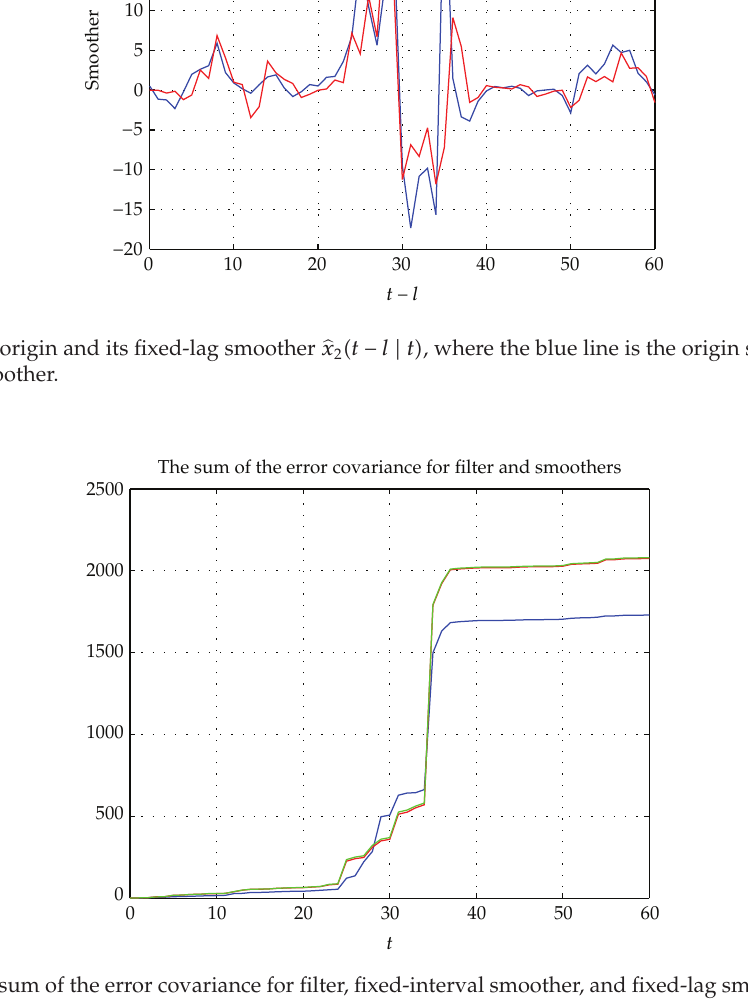
Figure 7: The sum of the error covariance for filter, fixed-interval smoother, and fixed-lag smoother, where the blue line is for the filter, the green line is for fixed-interval smoother, and the red line is for the fixed-lag